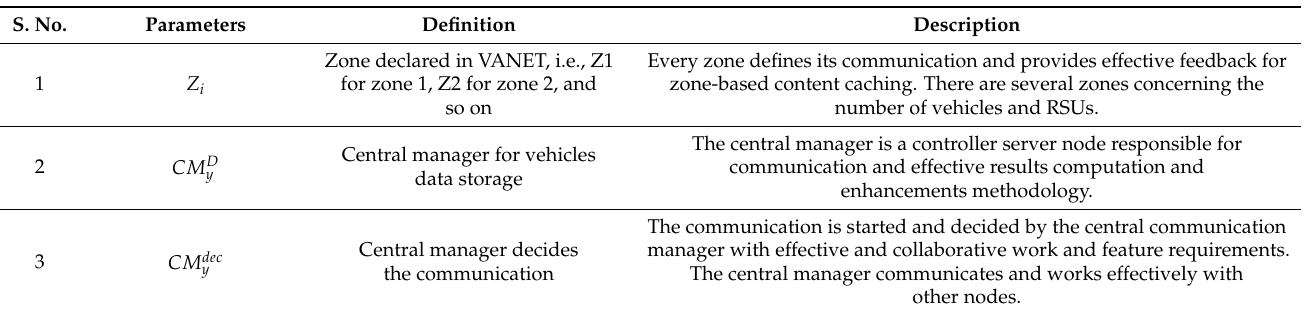
Table 2. Parameters with the description used for the proposed